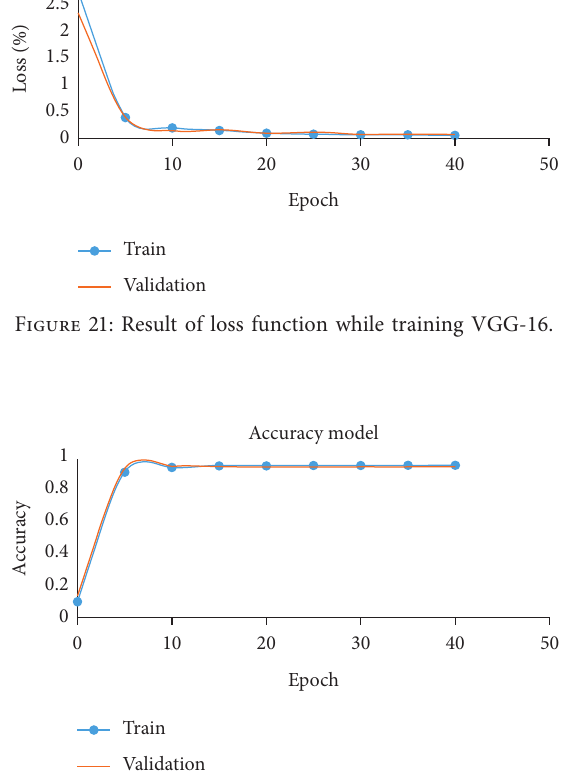
Figure 22: Result of accuracy function while training